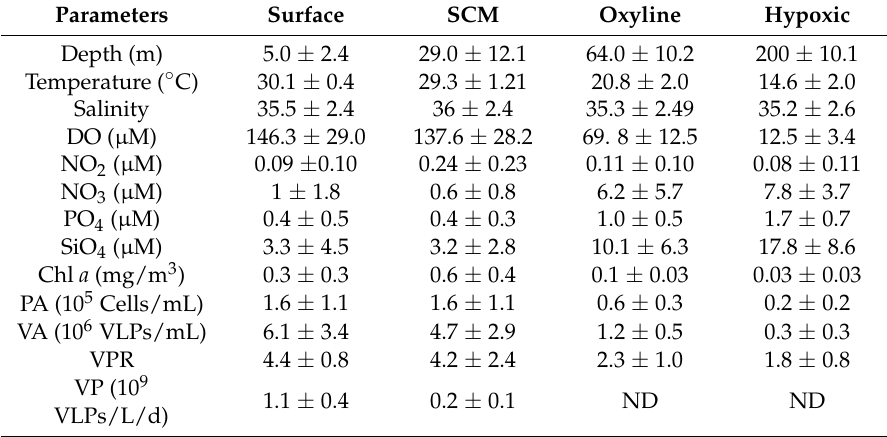
Table 2. Table showing the Mean ± SD of various biotic and abiotic variables measured at surface, surface chlorophyll maxima (SCM), oxycline, and hypoxic waters in the present study. Abbreviations used: viral abundance (VA), prokaryotic abundance (PA), virus to prokaryote ratio (VPR), viral production (VP), Chlorophyll a (Chl a ), dissolved oxygen (DO), nitrate (NO 3 ), Nitrite (NO 2 ), Phosphate (PO 4 ), and silicate (SiO 4